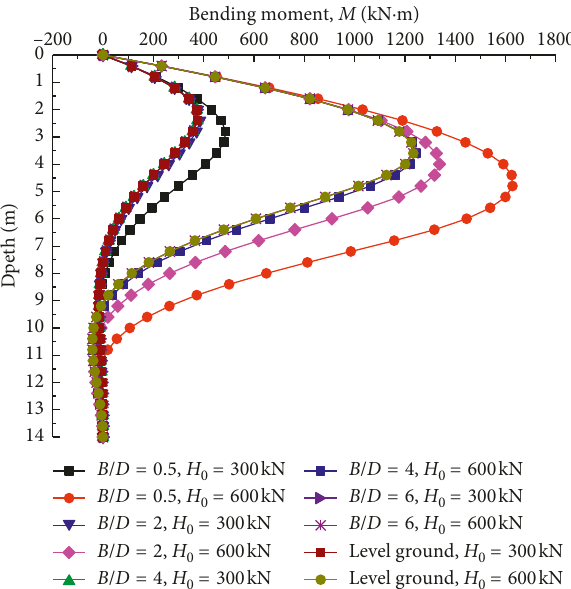
Figure 18: Bending moment variation along the depth of pile for θ 10 ° for different slope angle. (cid:31)